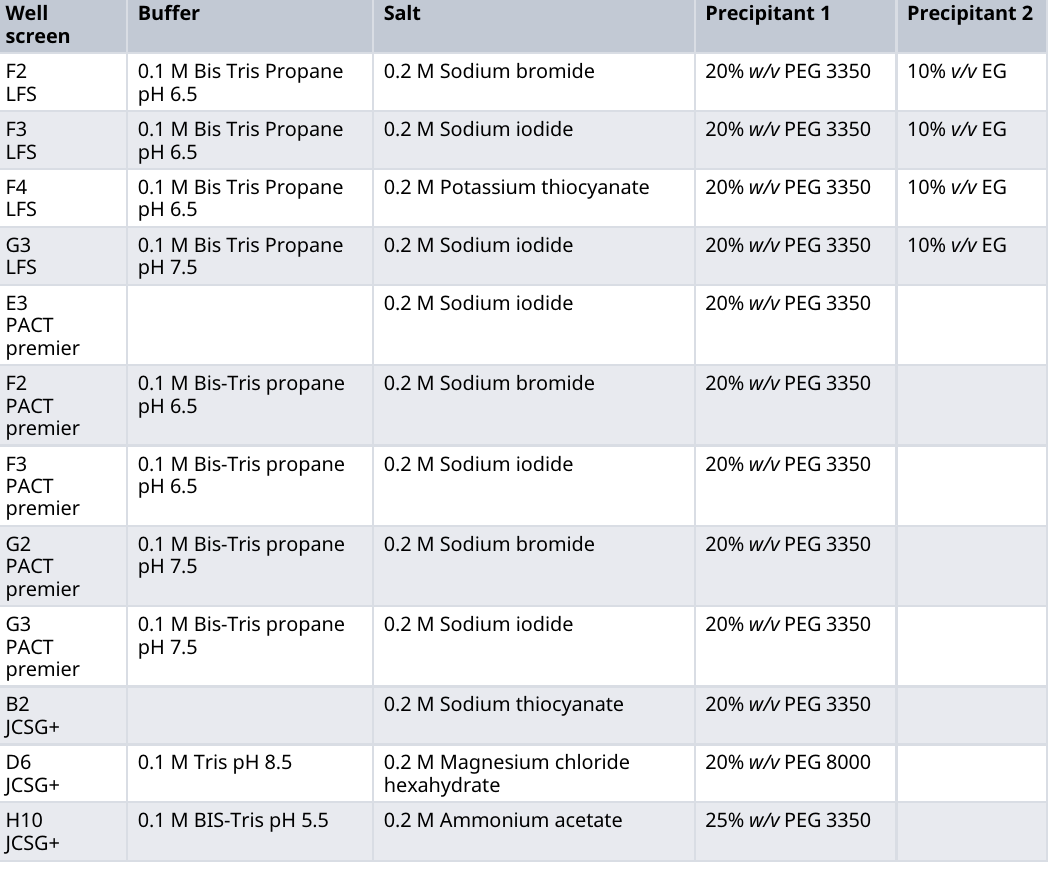
Table1. ConditionsinwhichcrystalsofPaFabB C161A(withoutHis-tag)wereformed. (PEG-polyethyleneglycol; EG-ethylene glycol.) Well